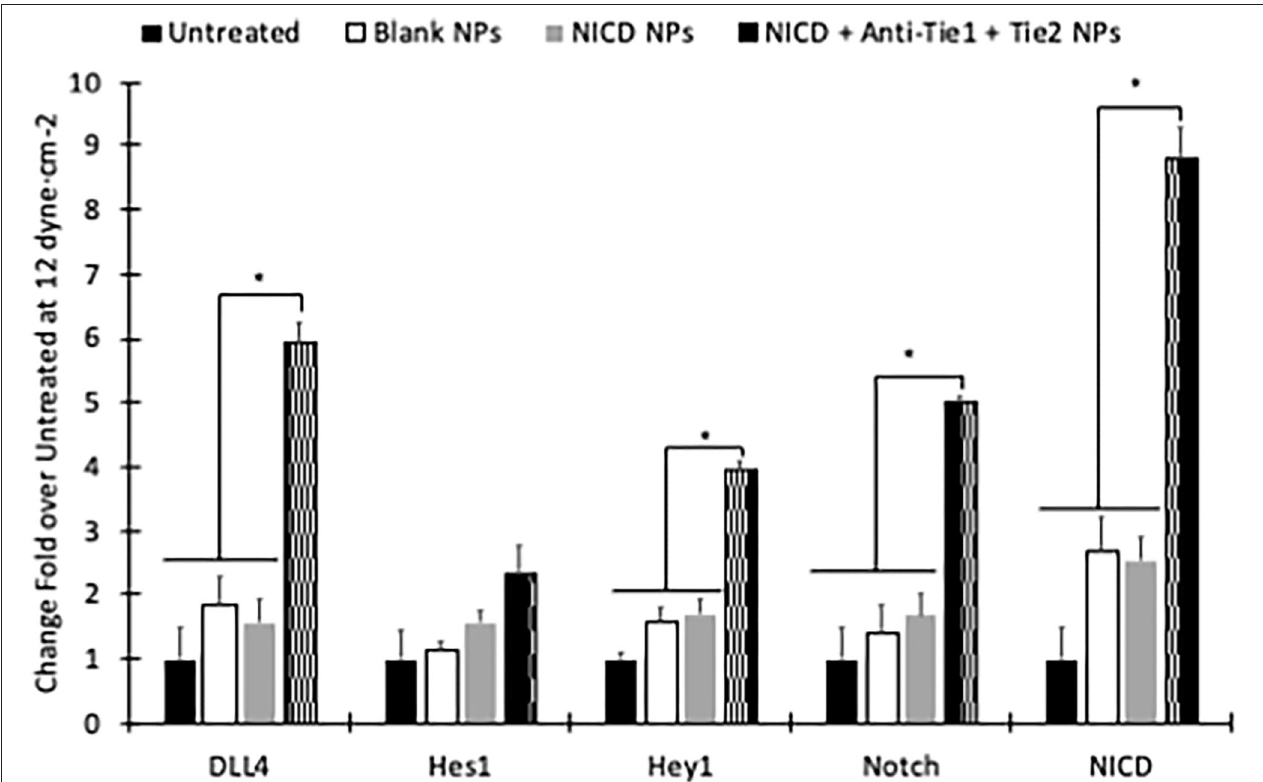
FIGURE 7 | NICD plasmid-loaded nanoparticles can enhance NICD expression in dynamic culture conditions. RT-PCR results showing that NPs conjugated to anti-Tie2 + Tie1 significantly upregulate DLL4, Hey1, Notch Receptor, and NICD in 12 dyne · cm − 2 flow conditions. *NICD + Anti-Tie1 + Tie2 is significantly higher mRNA expression evaluated with one-way ANOVA per gene group ( p <